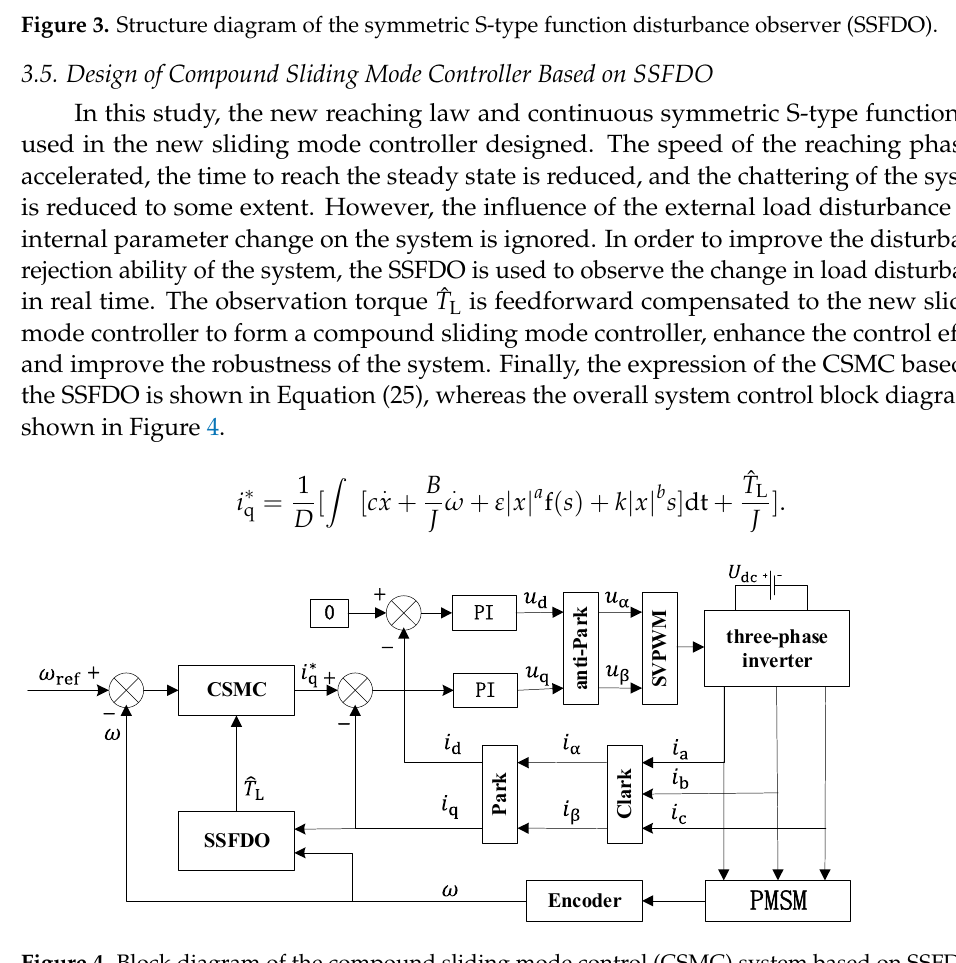
Figure 4. Block diagram of the compound sliding mode control (CSMC) system based on SSFDO.